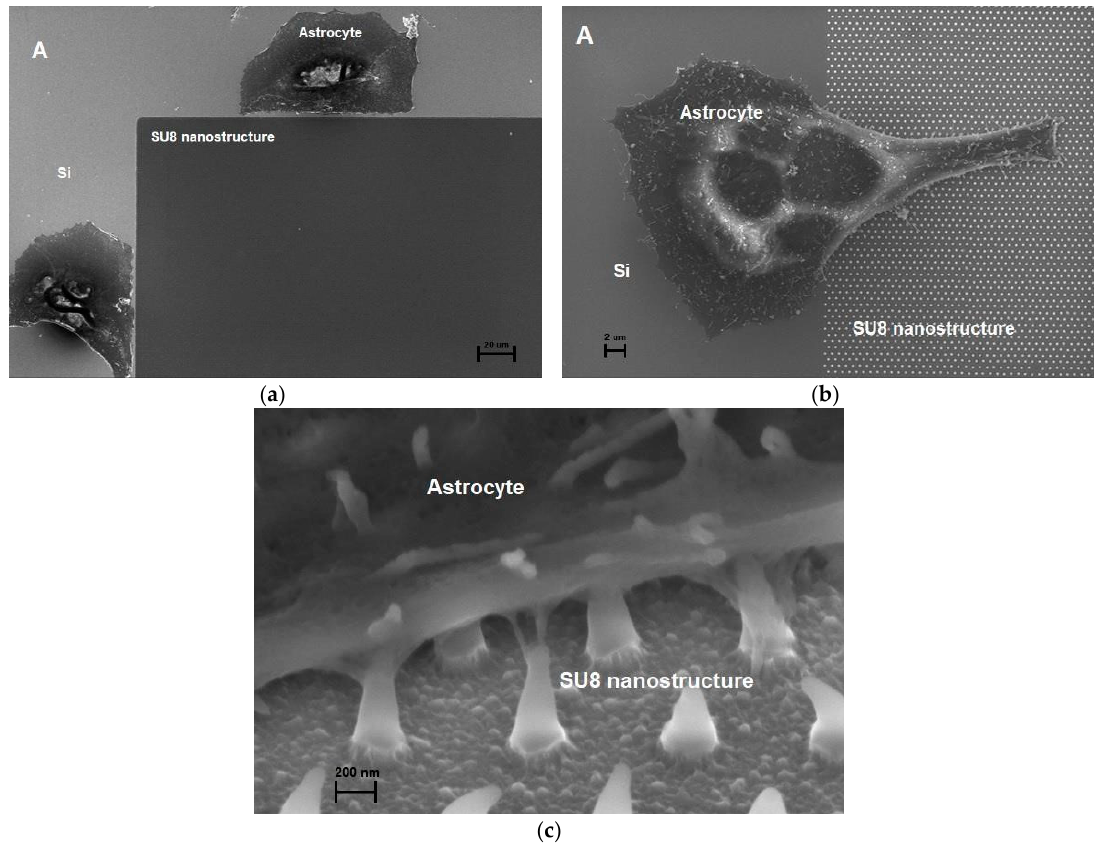
Figure 3. Primary mouse astrocytes avoid type A nanostructured SU-8 surfaces ( a ), while spread over type B nanostructured surfaces ( b ) and attach to spiky SU-8 nanopillars ( c